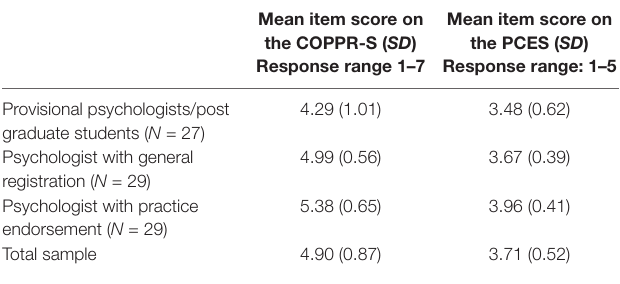
TABLE 1 | Average item score for each psychologist registration